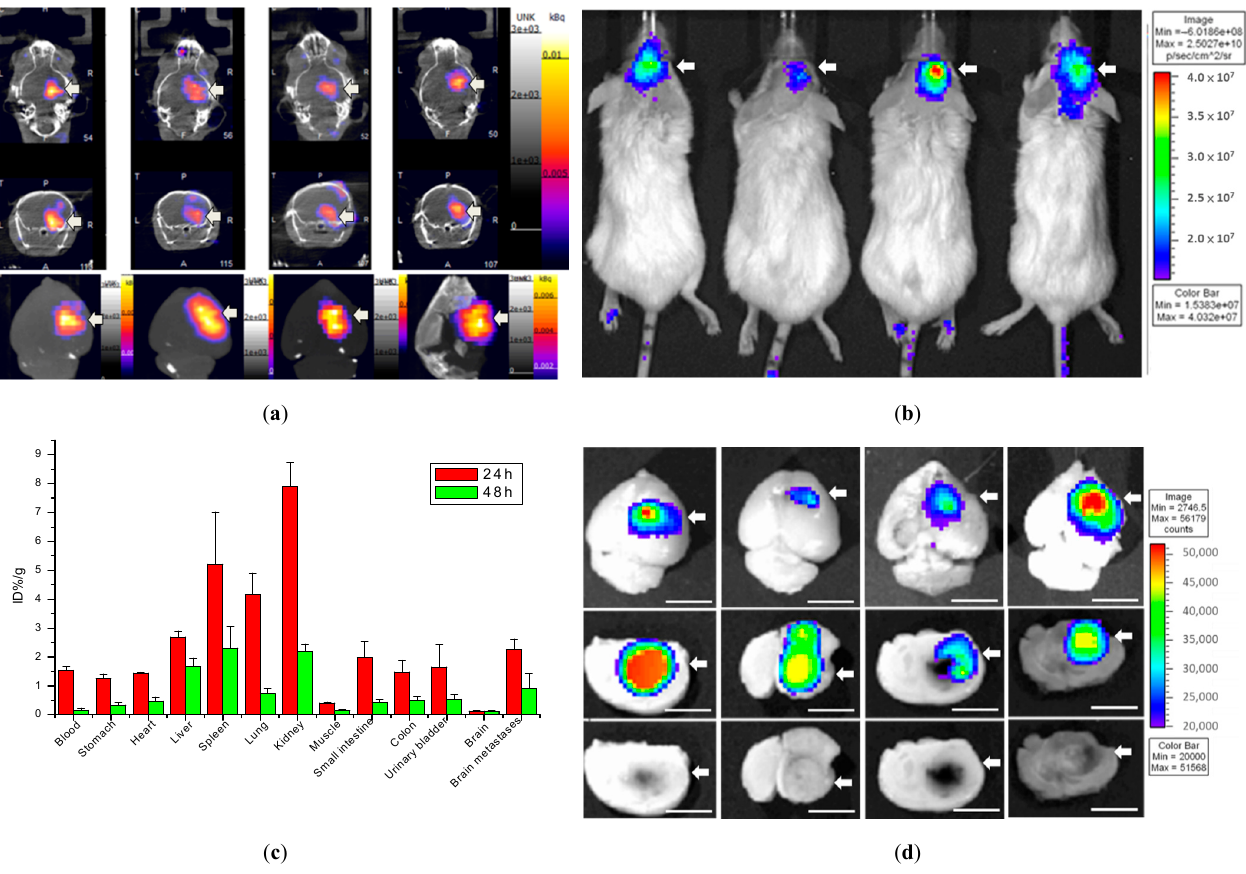
Figure 4. Biodistribution of 111 In-DOTA-NIR790 in mice with brain metastasis of 4T1 breast cancer. ( a ) SPECT/CT images, ( b ) NIRF images, ( c ) biodistribution, and ( d ) ex vivo NIRF images at 48 h after administration ( n = 4 at each time point). Arrow indicates tumor. The scale bar is 5 mm.